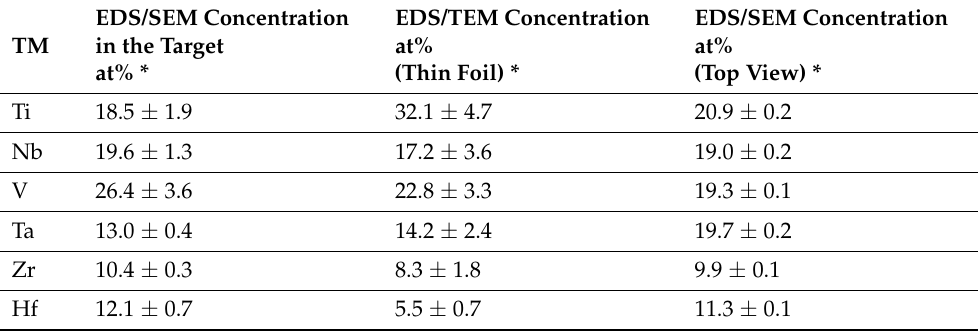
Table 3. Average concentrations of transition metal elements in the target compared to those in the HT-6TM-0N coating obtained on thin foil by EDS/TEM and in top view EDS/SEM from a large area (900 × 680 µ m 2